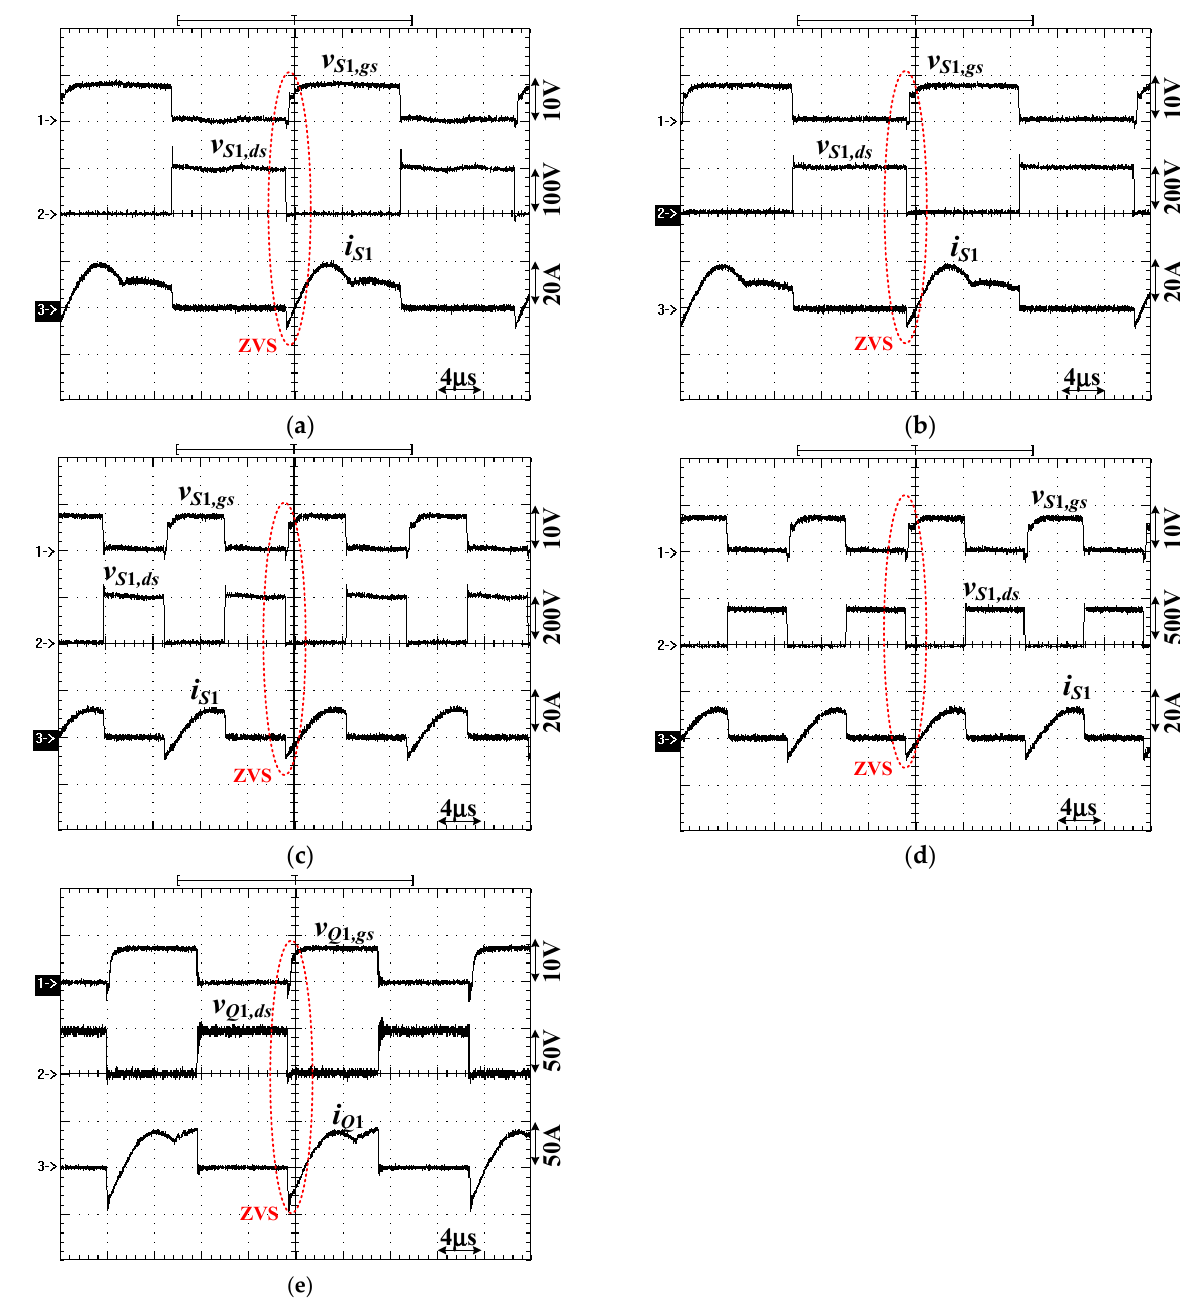
Figure 16. Measured switch waveforms at full load: ( a ) S 1 at V in = 100 V and forward power operation, ( b ) S 1 at V in = 198 V and forward power operation, ( c ) S 1 at V in = 202 V and forward power operation, ( d ) S 1 at V in = 400 V and forward power operation, ( e ) Q 1 at reverse power operation.